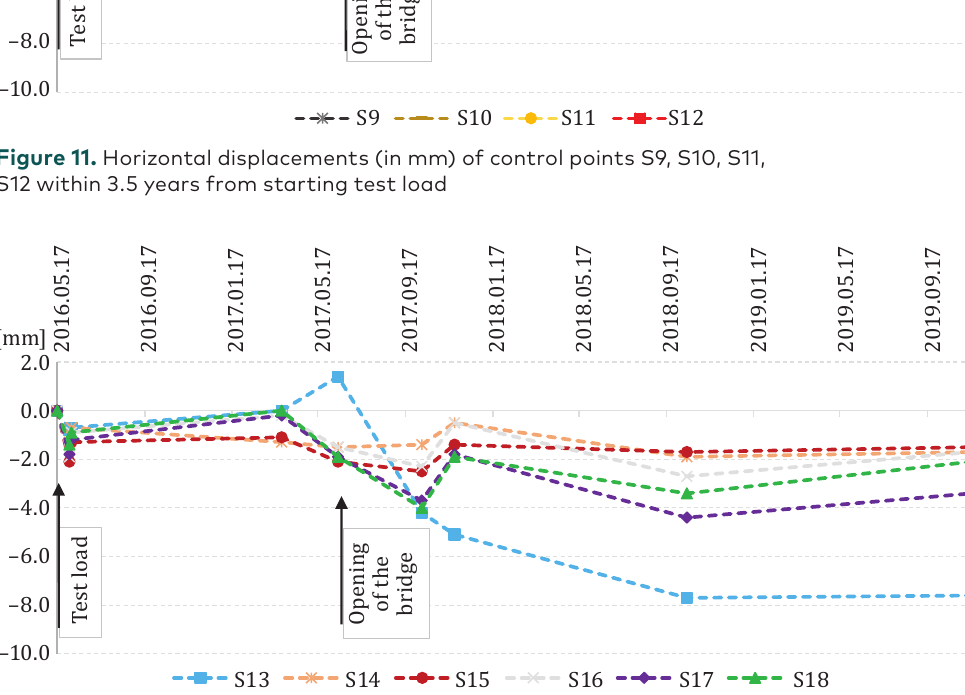
Figure 12. Horizontal displacements (in mm) of control points S13, S14, S15, S16, S17, S18 within 3.5 years from starting test load